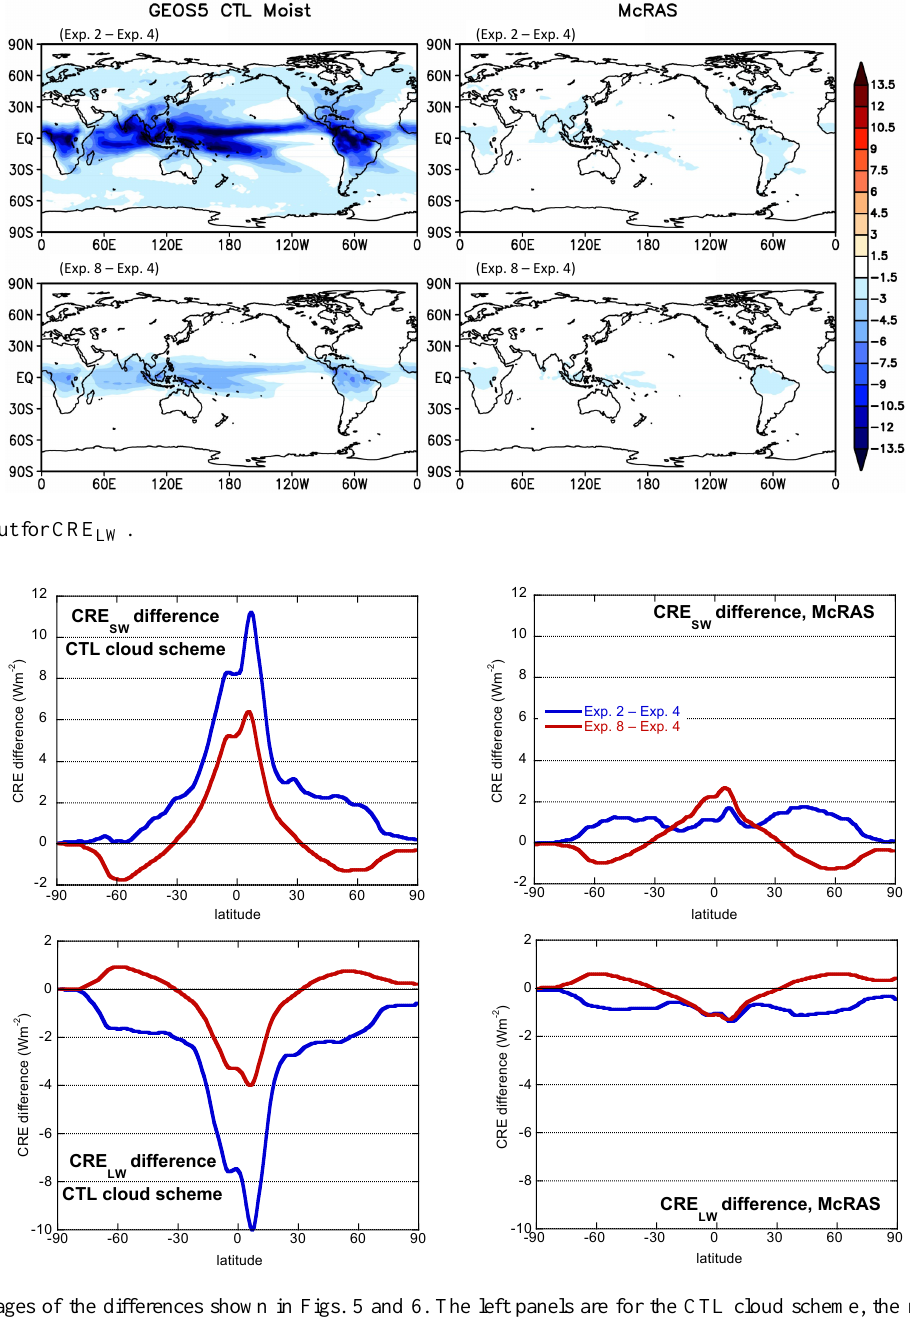
Fig. 7. Zonal averages of the differences shown in Figs. 5 and 6. The left panels are for the CTL cloud scheme, the right panels are for McRAS-AC. Top panels are for CRE SW , while the bottom panels are for CRE LW .